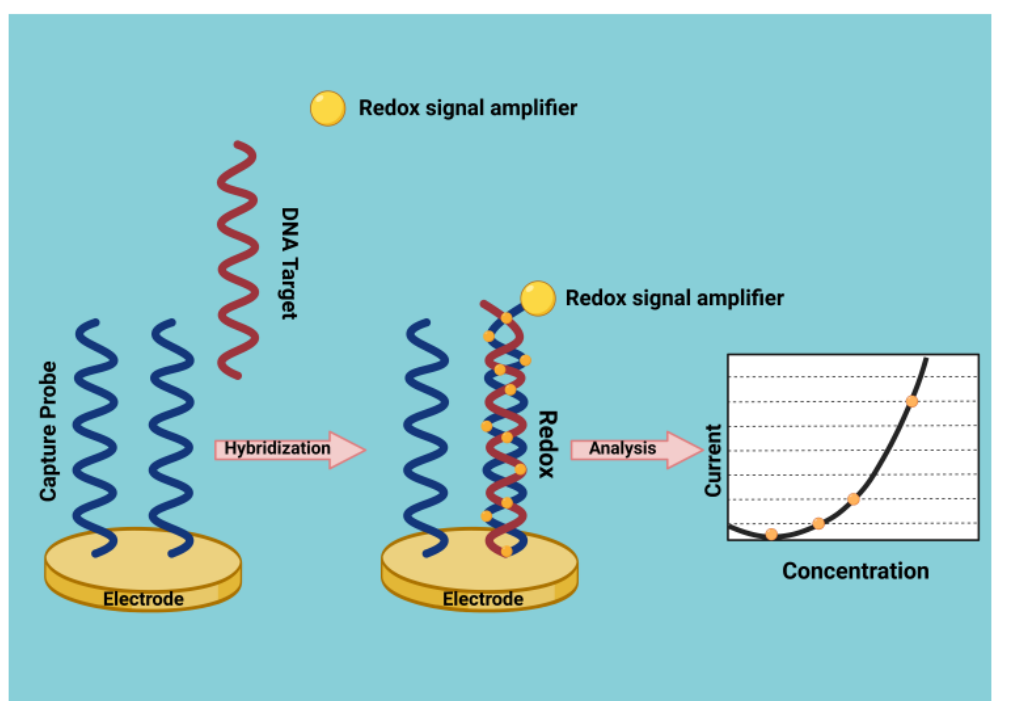
Figure 1. Method for the electrochemical detection of DNA hybridization.